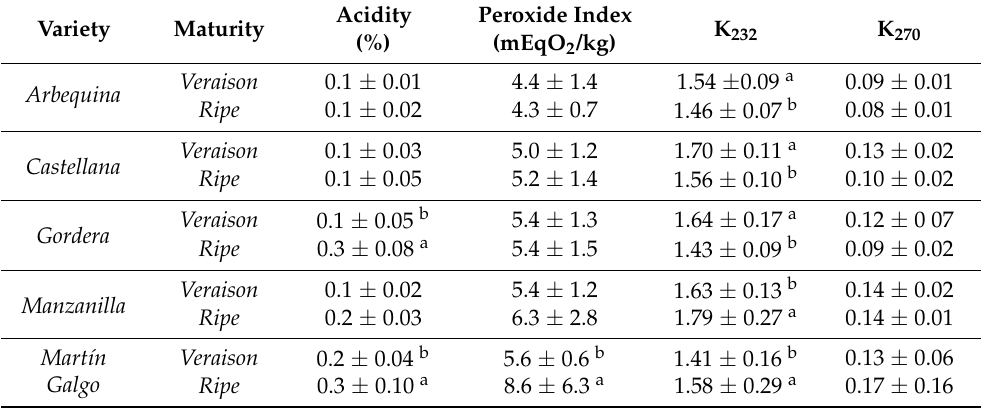
Table 1. Regulated physicochemical parameters for the virgin olive oils produced with the variety of olives grown in the Aceite de la Alcarria PDO (veraison and ripe). The data show the mean value and standard deviation of the oils across the four consecutive olive crop seasons under